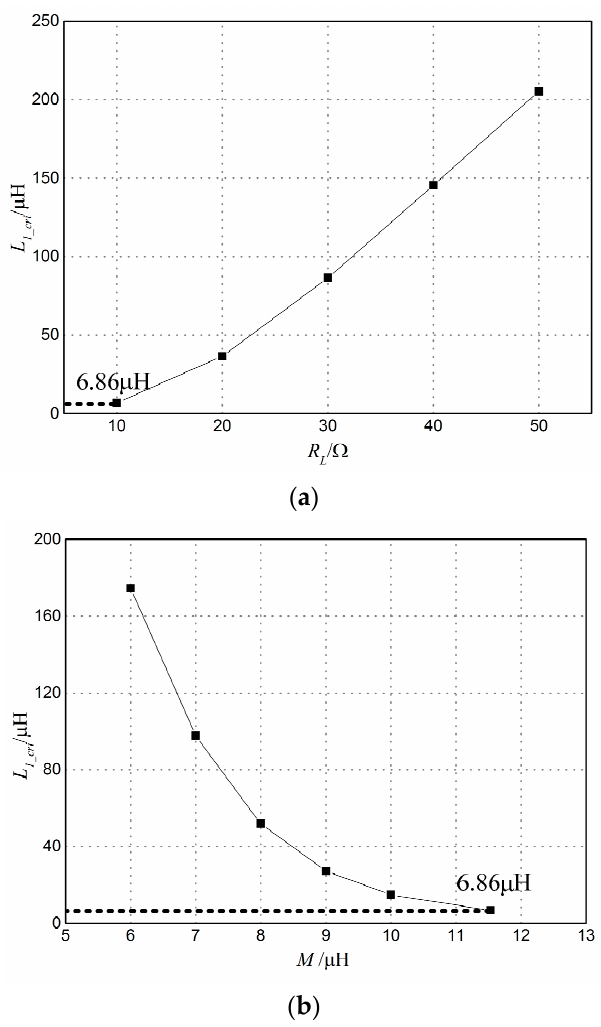
Figure 15. The critical value L 1 _cri : ( a ) R L varies, M = 11.53 μ H; ( b ) M varies, R L = 10 Ω .